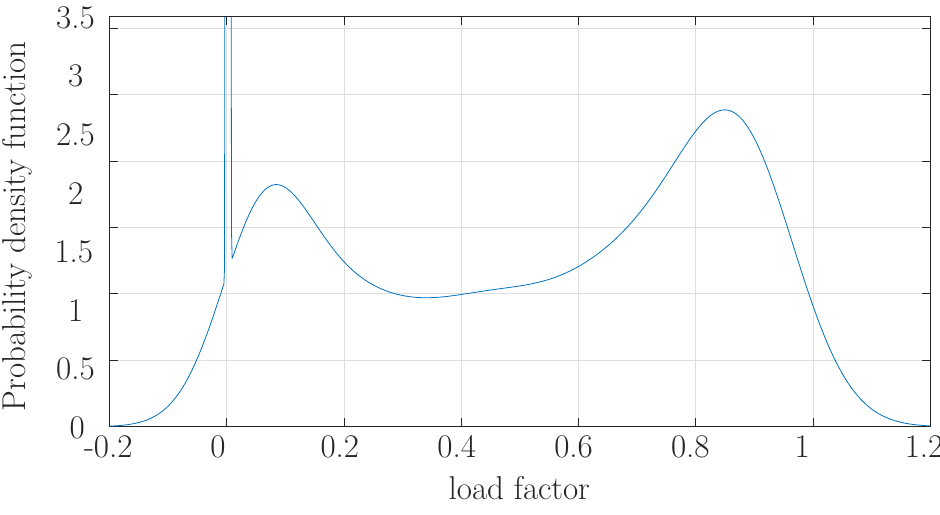
Figure 7. Probability density of production rate daily